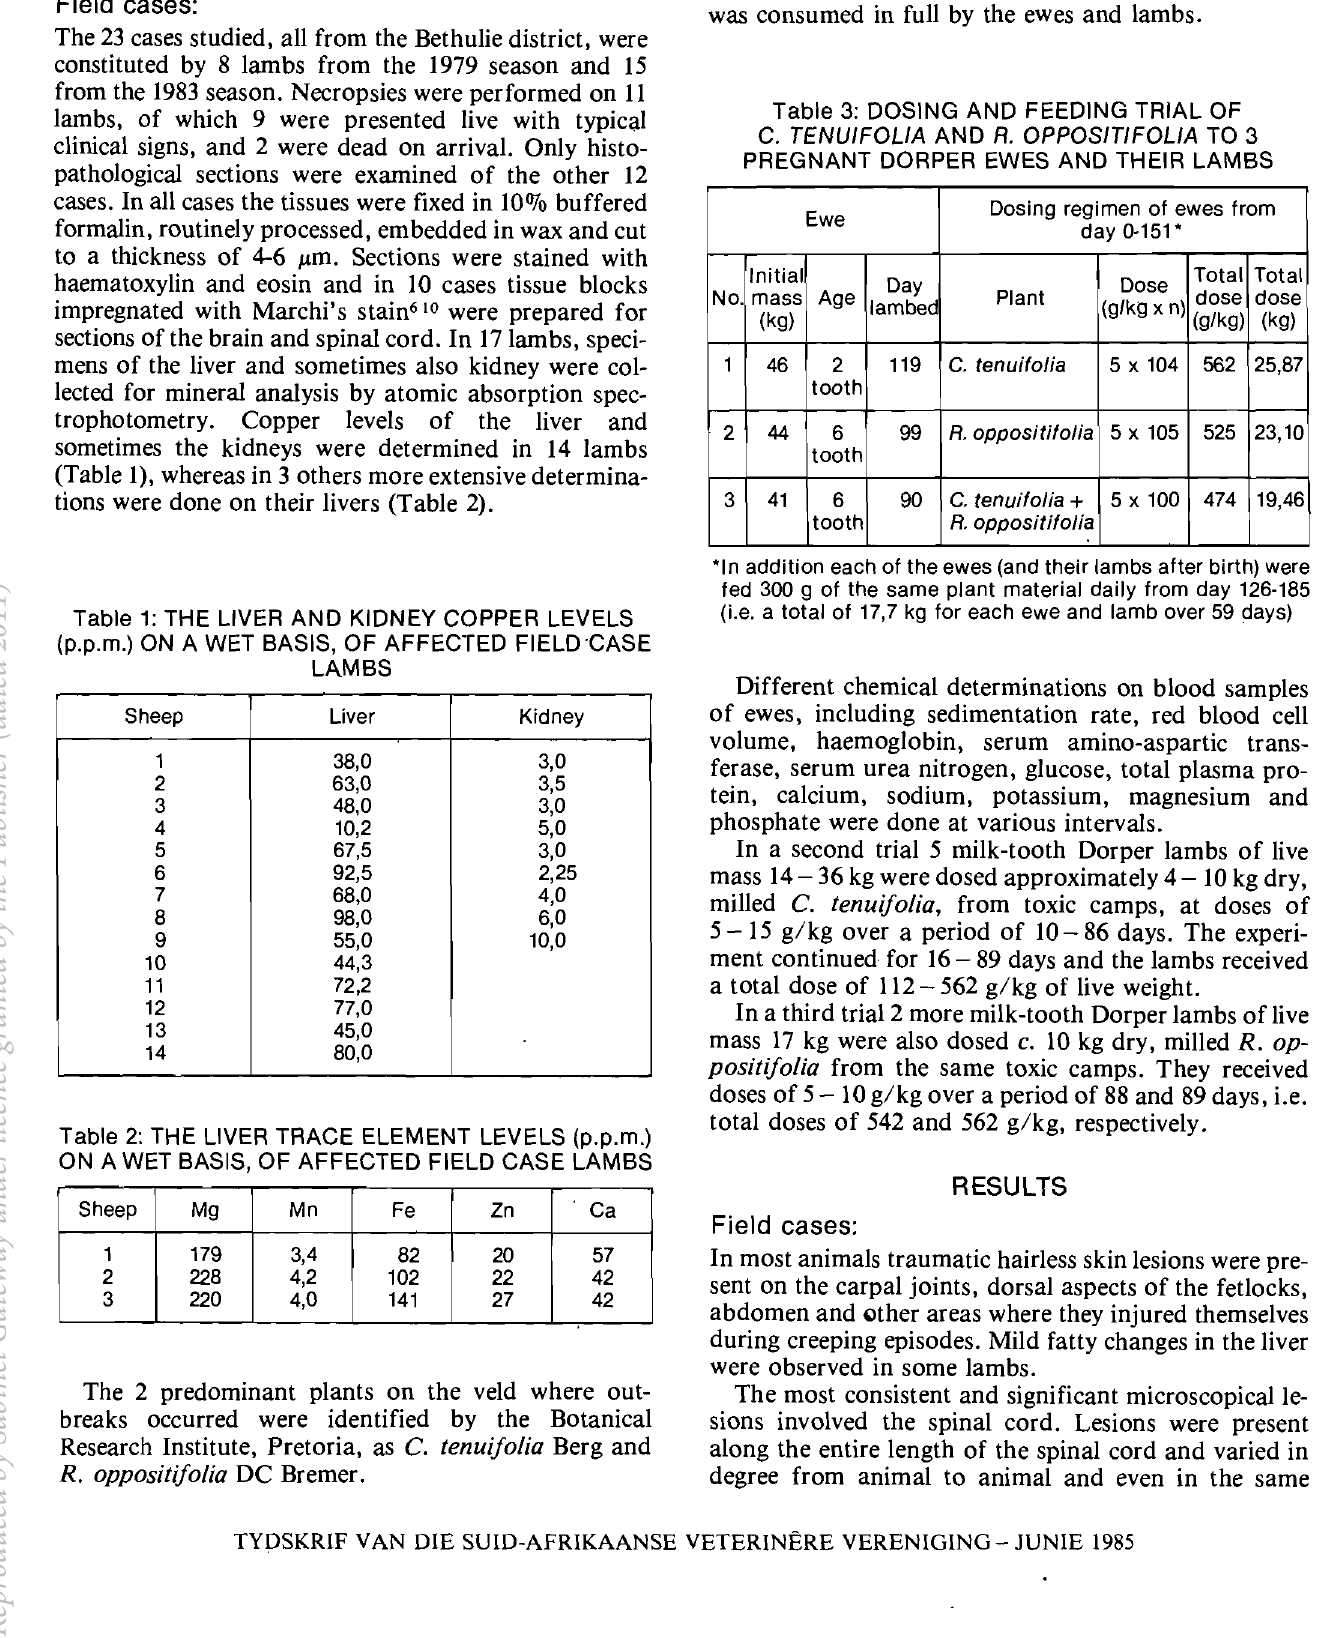
Table 3: DOSING AND FEEDING TRIAL OF C. TENUIFOLIA AND R. OPPOSITIFOLIA TO 3 PREGNANT DORPER EWES AND THEIR